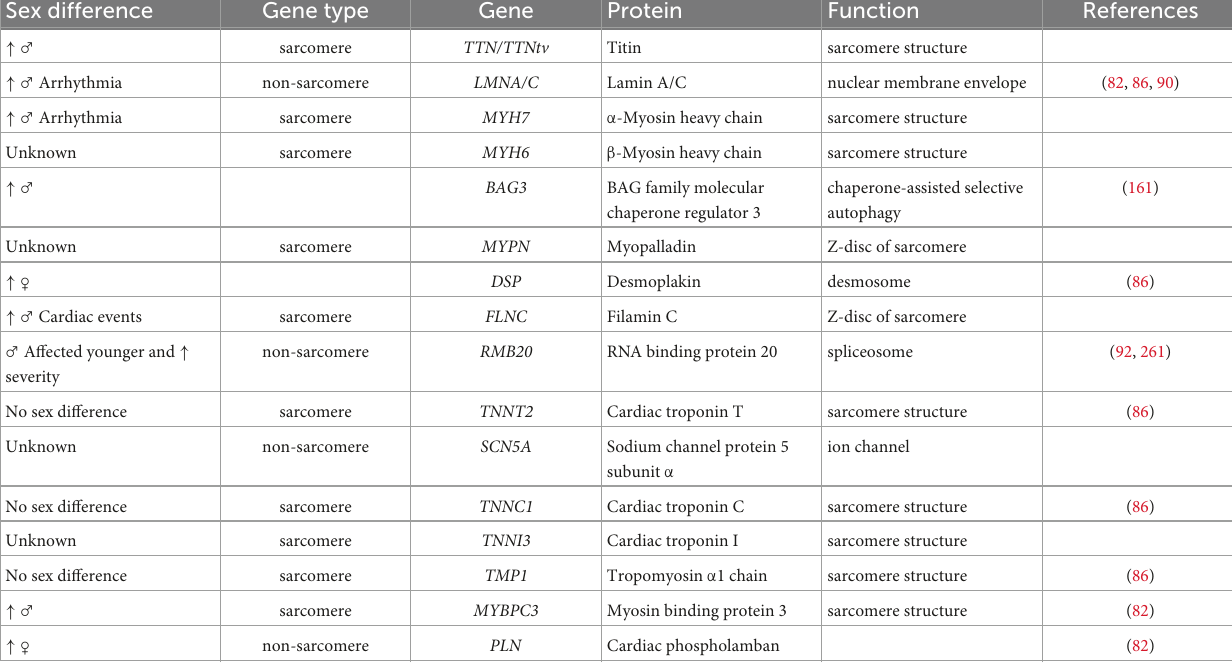
TABLE 3 Sex differences in the most common familial DCM-linked genes in descending order. Sex difference Gene